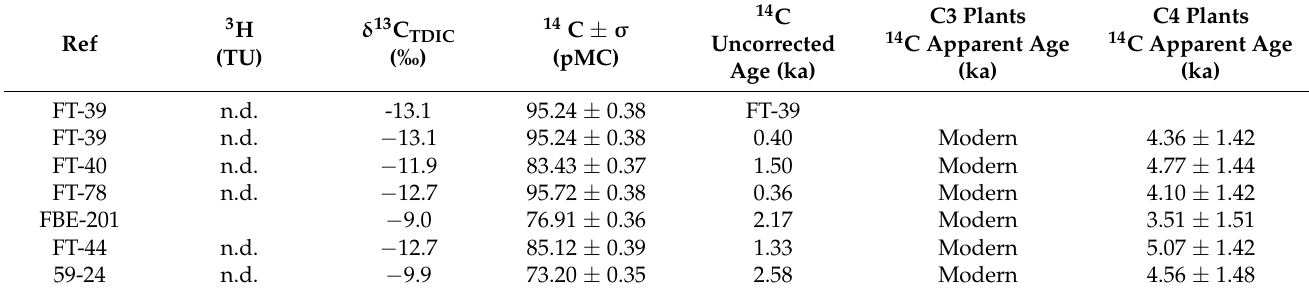
Table 2. Apparent radiocarbon groundwater ages, using C4 and C3 plants (n.d. stands for not